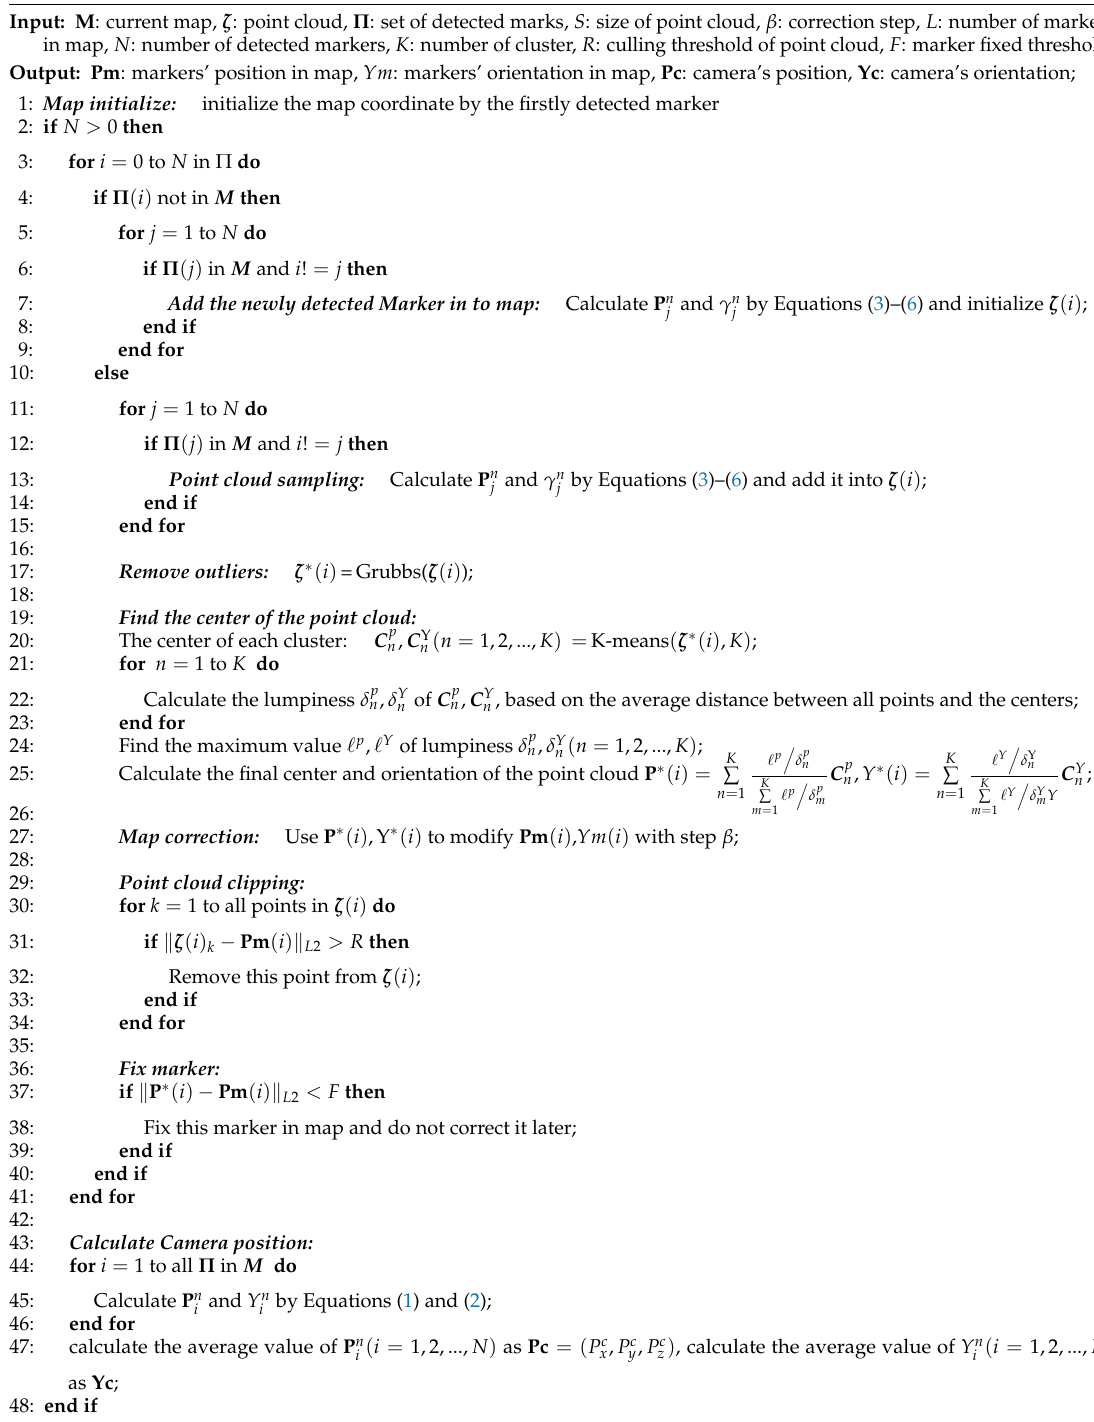
Algorithm 1 Pseudo-Code of the ArUco Mapping